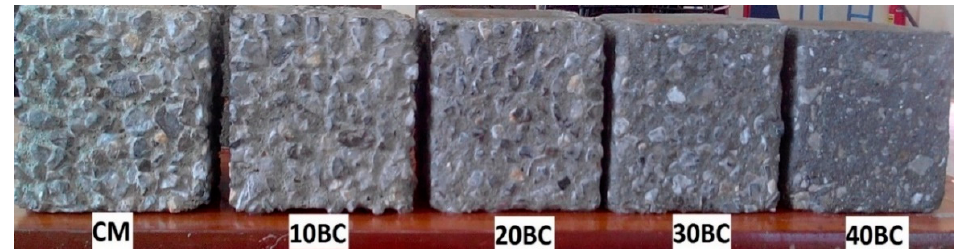
Figure 17. Specimens after immersion in sulfuric acid.